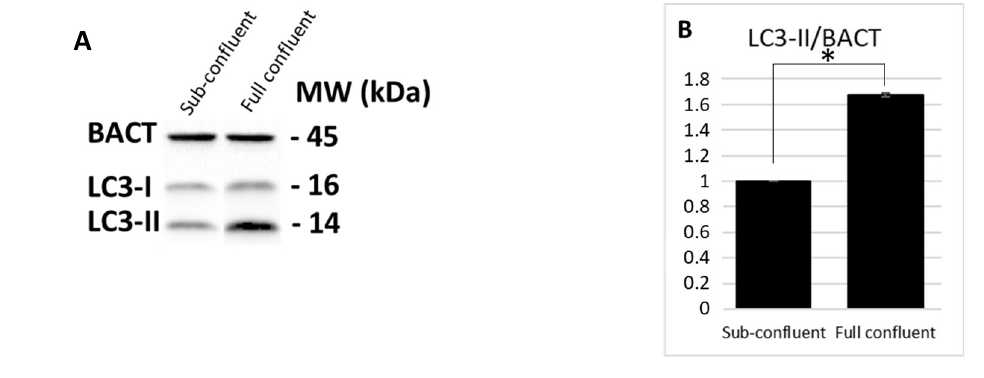
Figure 1. LC3-II expression levels of Caco-2 cells at different confluences. LC3-II and BACT protein expression were analyzed through immunoblotting ( A ) and densitometric analyses ( B ). LC3-II was normalized to BACT levels as recommended [23]. Normalized values are reported on the y-axis as arbitrary units. Molecular weights (kDa) and standard error (SE) bars are reported. The asterisks indicate p < 0.05, one-way Anova. The experiments were performed in duplicate.